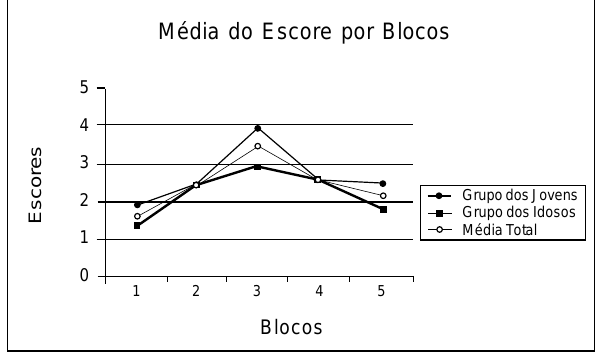
Figura 3 . Média dos escores por bloco, segundo critérios de frequência para a amostra total, o grupo de idosos e o grupo de